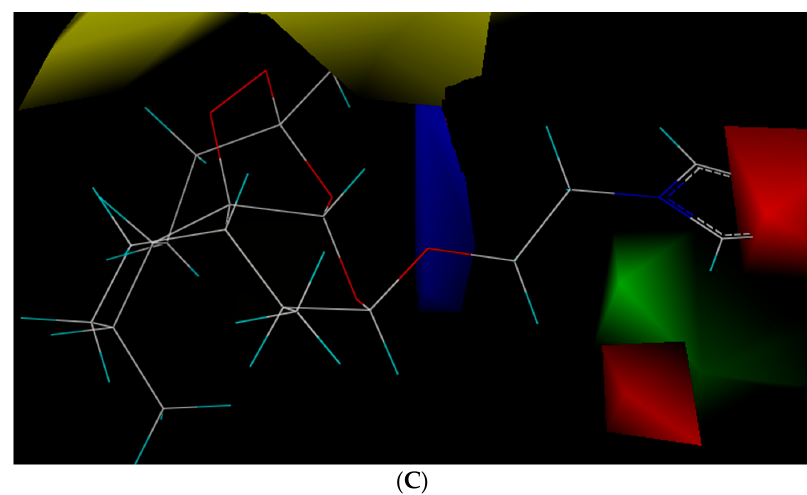
Figure 1. Three-dimensional structure–activity relationship (3D-SAR) analysis. ( A ) DHA7 as a molecular template; ( B ) A total of 18 compounds were used for database alignment. The molecular energy minimization of each compound was calculated in the compute mode; ( C ) Comparative molecular field analysis results (including steric and electrostatic fields).